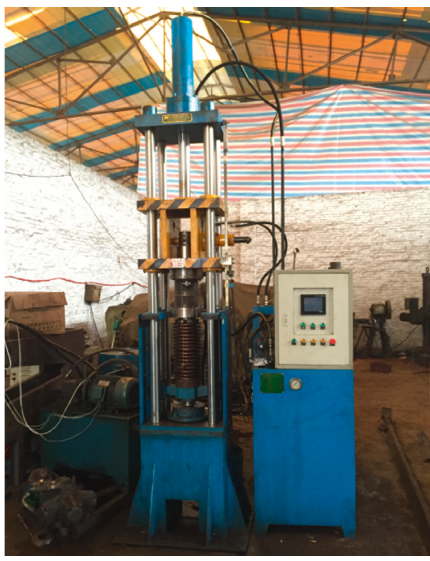
Figure 11: Developed industrial prototype machine.